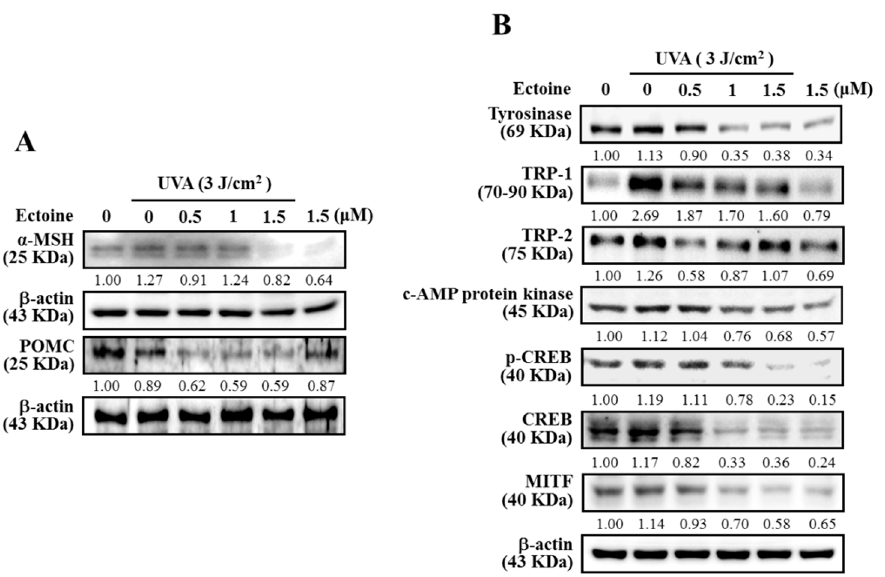
Figure 2. Ectoine suppresses UVA-induced POMC and α -MSH expression in HaCaT cells. ( A ) Western blotting showed us protein levels of α -MSH and POMC. Cells were pre-treated with Ectoine (0–1.5 μ M) for 24 h and then irradiated or not with 3 J/cm 2 UVA. ( B ) Effect of HaCaT conditioned medium on B16F10 cells melanin synthesis. HaCaT cells were pre-treated with vehicle (PBS) or Ectoine (0.5–1.5 μ M) for 24 h. Subsequently, these cells were exposed or non-exposed to the 3 J/cm 2 UVA-irradiation. After 1–24 h, the conditioned medium (10 mL/100 mm dish) was collected and tested on B16F10 cells for the expression of various proteins through western blot method. Lanes 1 and 2 were indicating the experimental conditions of conditioned medium obtained from vehicle (PBS) pre-treated and UVA non exposed (lane #1) and exposed (lane #2). Whereas, lanes 3–5, and 6 were indicating the experimental conditions of conditioned medium obtained from Ectoine pre-treated (0.5–1.5 μ M) and UVA exposed, and non-exposed, respectively. Western blot analysis measured the protein levels of tyrosinase, TRP-1, TRP-2 (for 24 h), c-AMP protein kinase (for 1 h), p-CREB, CREB (for 2 h), and MITF (for 4 h).